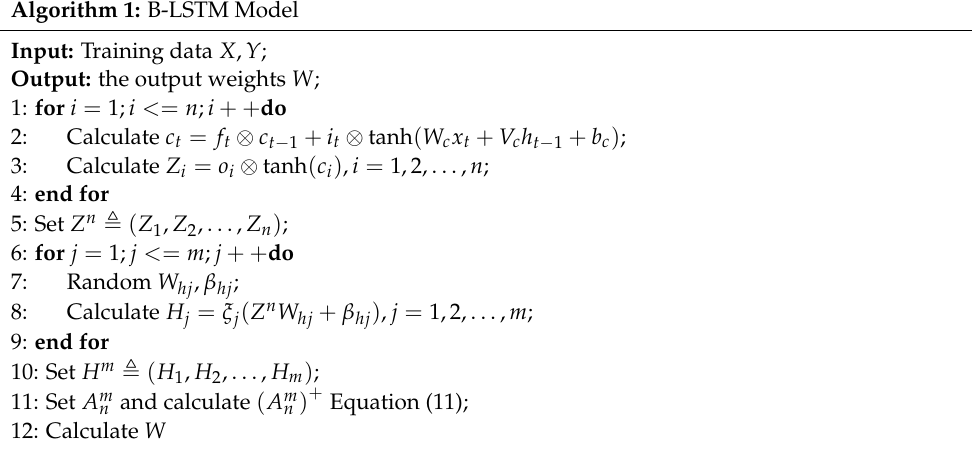
Algorithm 1: B-LSTM Model